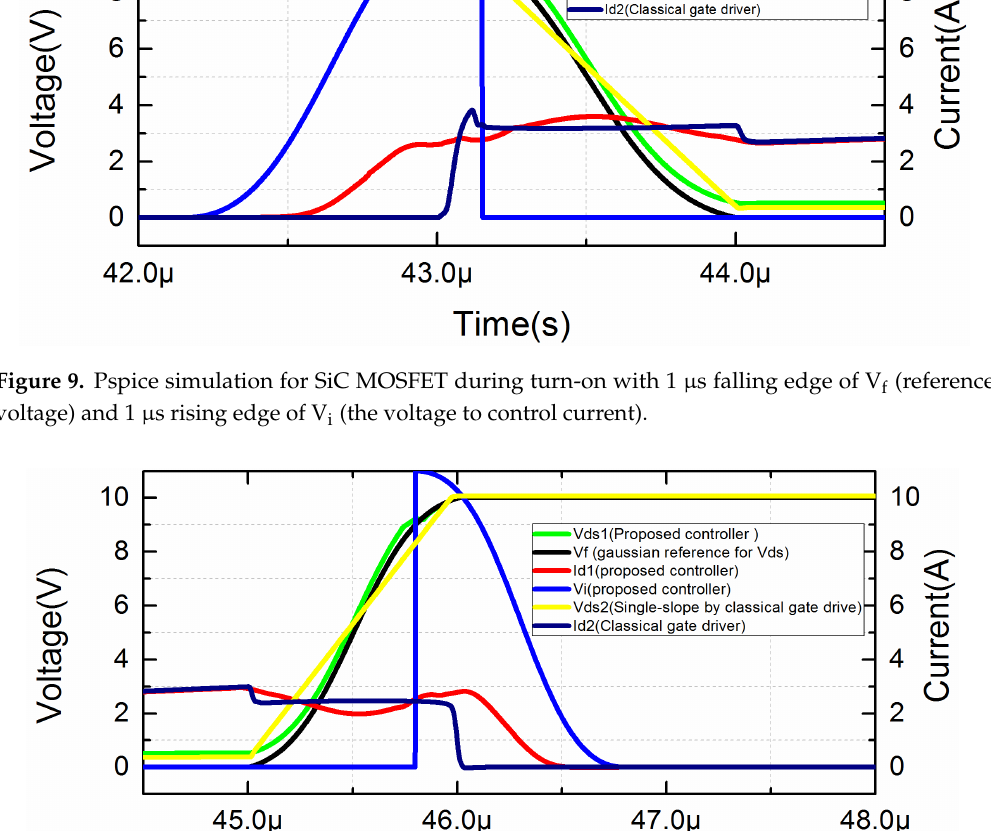
Figure 12. Pspice simulation SiC MOSFET during turn-off with 1 µs decline time of V f and 0.5 µs rise time of V i .